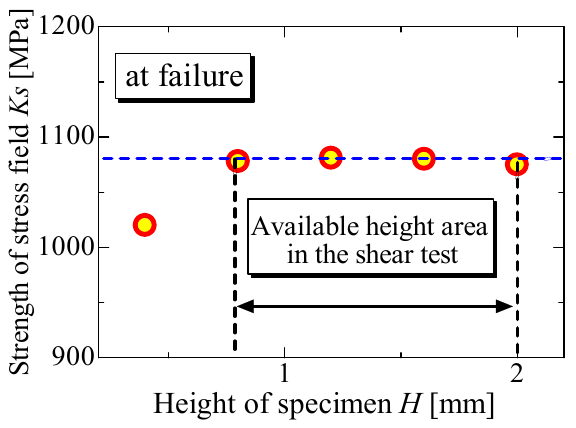
Figure 17. Shear stress distributions at failure for various specimen heights, in which virtually the same stress distributions can be observed.